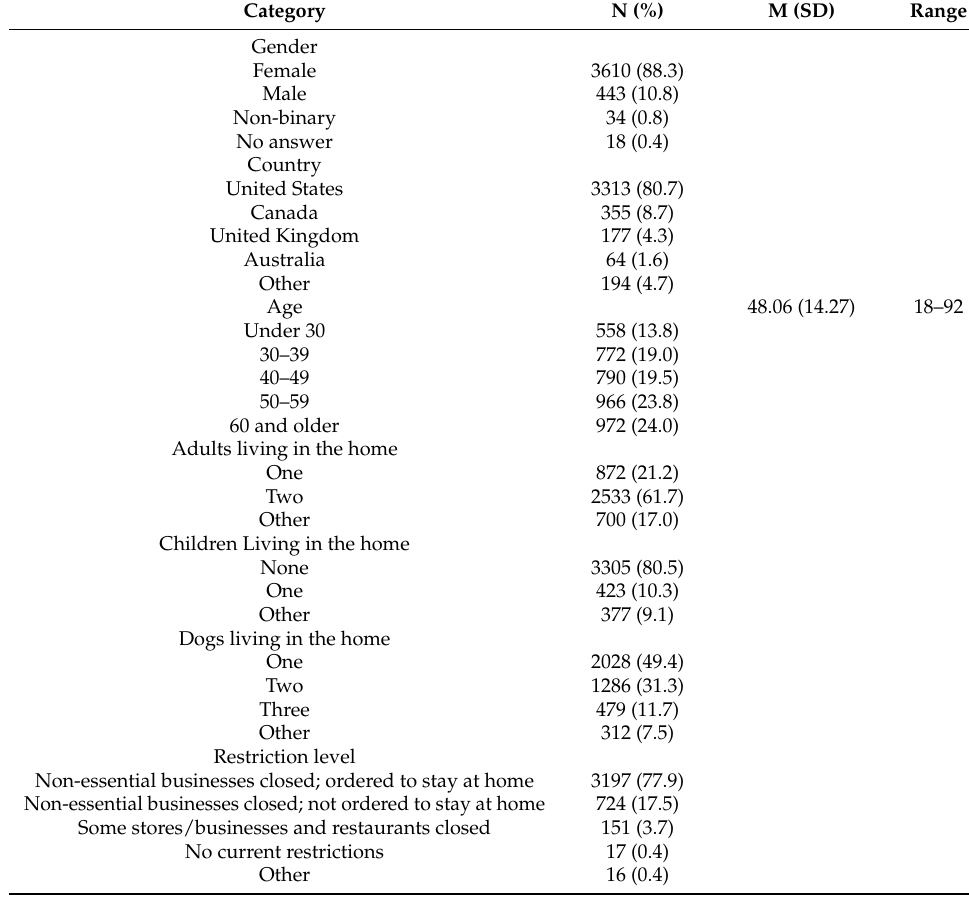
Table 1. Sample sociodemographics (N =